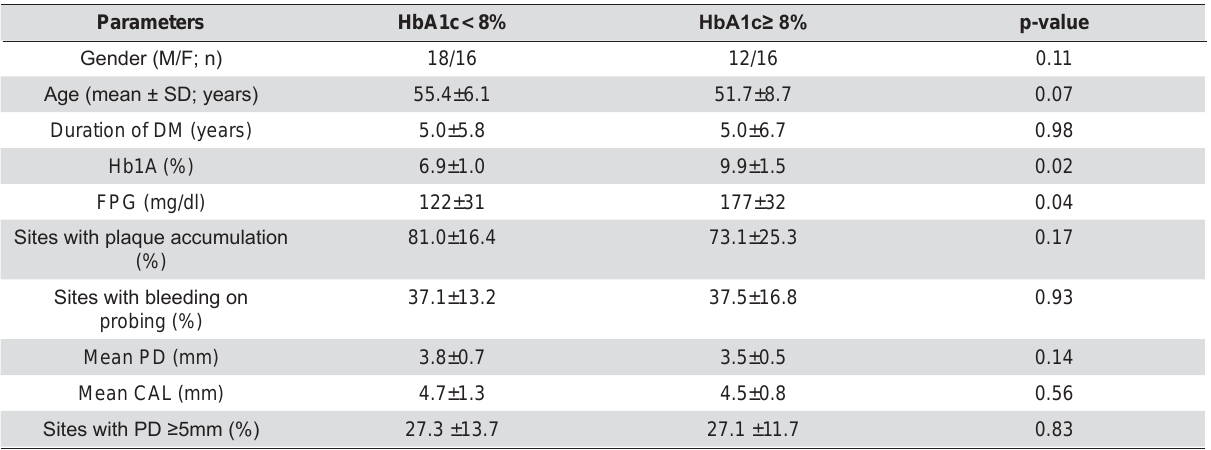
Table 1- Demographic characteristics, glycemic parameters (mean ± SD) and full-mouth clinical parameters (mean ± SD) of both groups of the study population